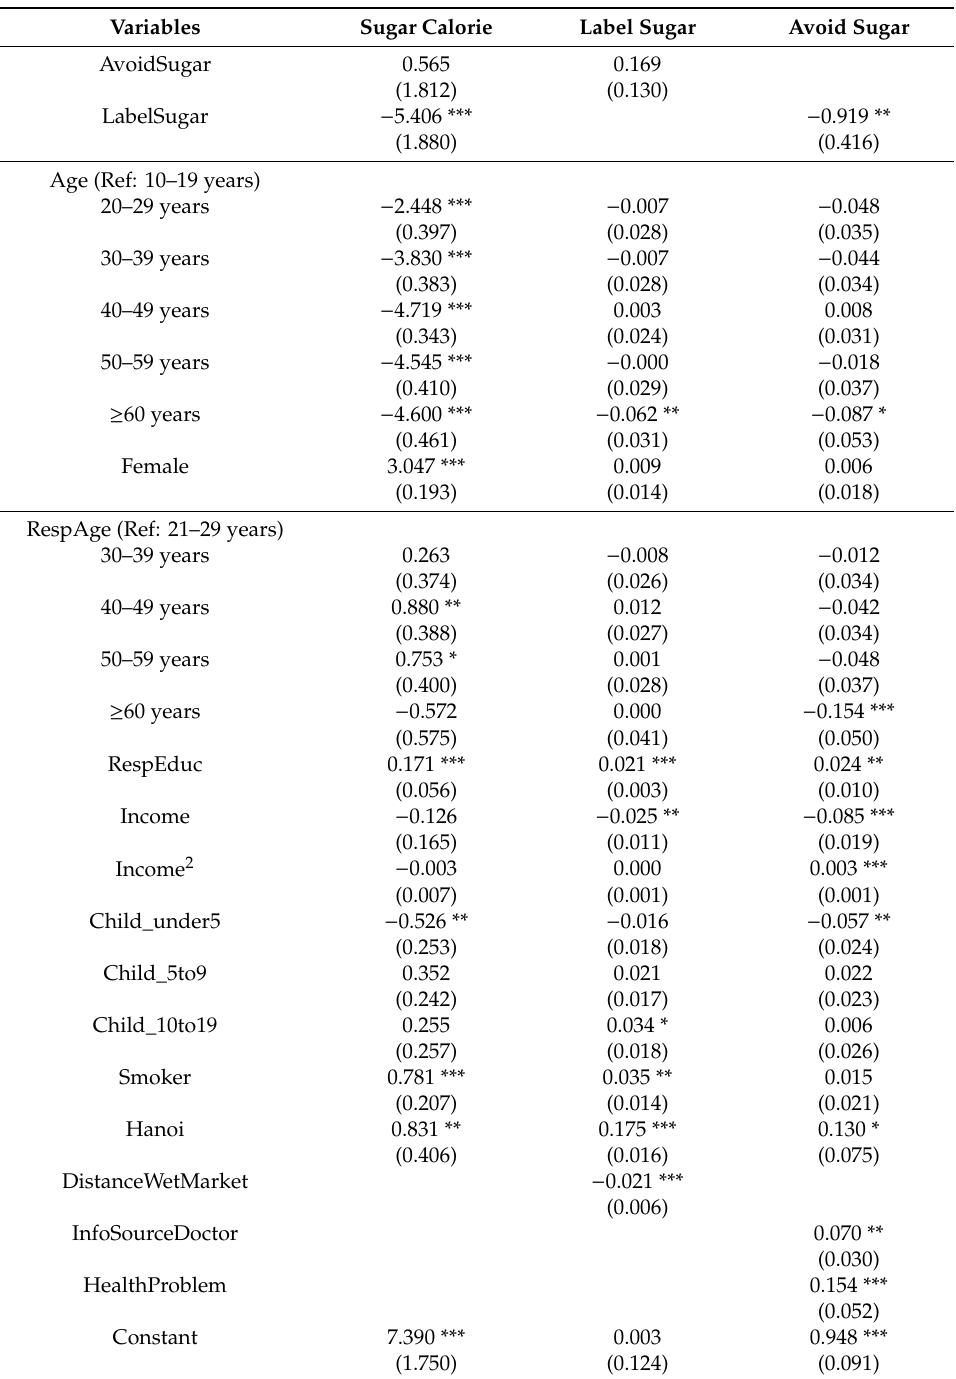
Table 2. Three-stage least squares (3SLS) estimates for full sample. (n =